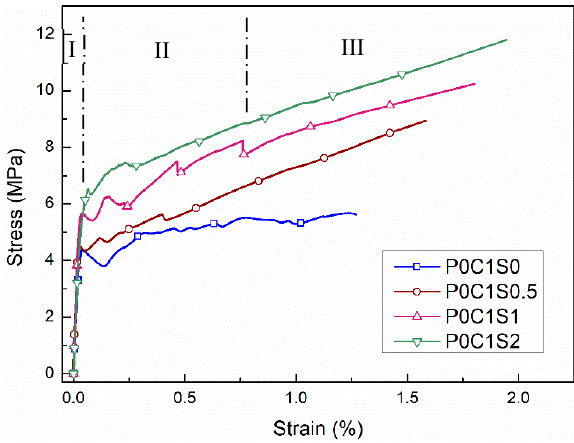
Figure 6. Typical tensile stress—strain curves of TRM specimens.